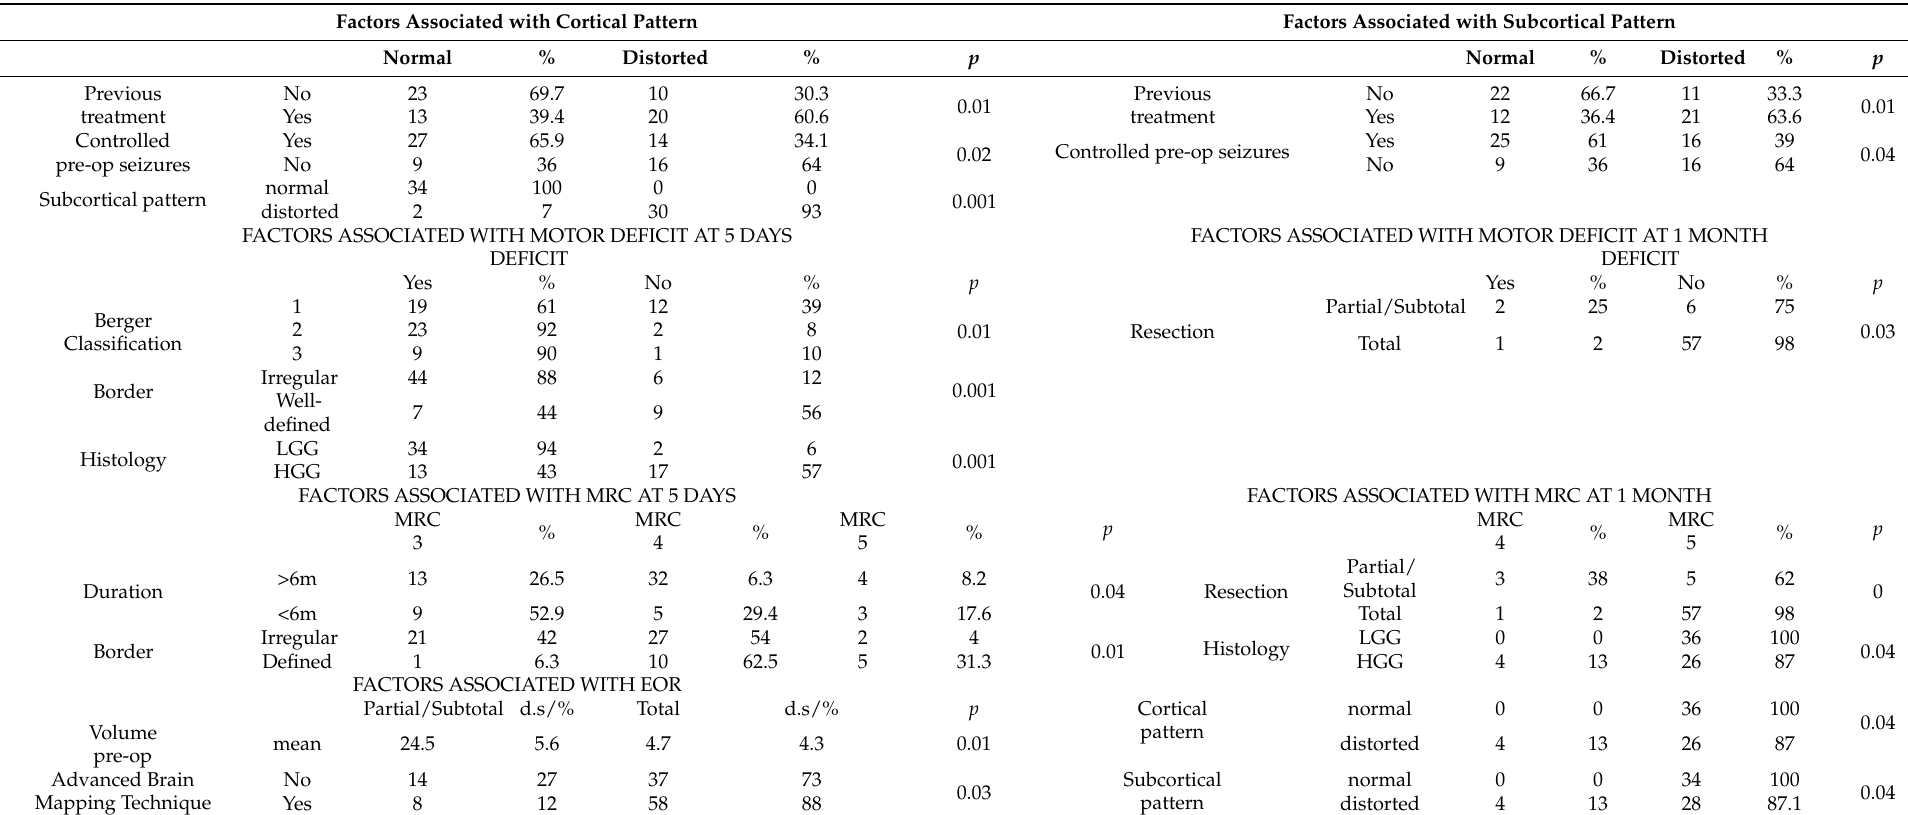
Table 2. Variables associated with the cortical or subcortical pattern, motor deficit and extent of resection: Fisher Exact tests or Pearson Chi-square tests were performed for all the associations, with the exception of the tumor volume variable, where a one-way ANOVA was used; only significant factors are shown. The Advanced Brain Mapping Technique analysis refers to the comparison of EOR between patients submitted to the advanced Brain Mapping technique (YES) and those (historical cohort of 51 patients) who were submitted to the standard mapping (NO,